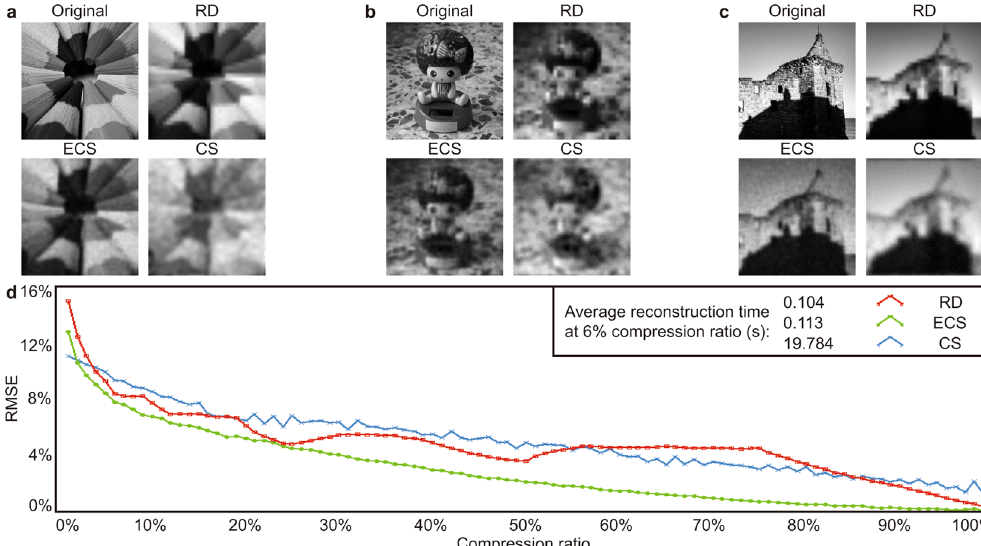
Figure 4. General scene reconstruction comparison. ( a – c ) Examples of general scene (Original), the reconstructed images using ‘Russian Dolls’ approach (RD), evolutionary compressive sensing (ECS), and conventional compressive sensing (CS). ( d ) Comparison based on relative error per pixel as a function of sampling ratio. Average reconstruction times at 6% sampling ratio for three approadches are given as